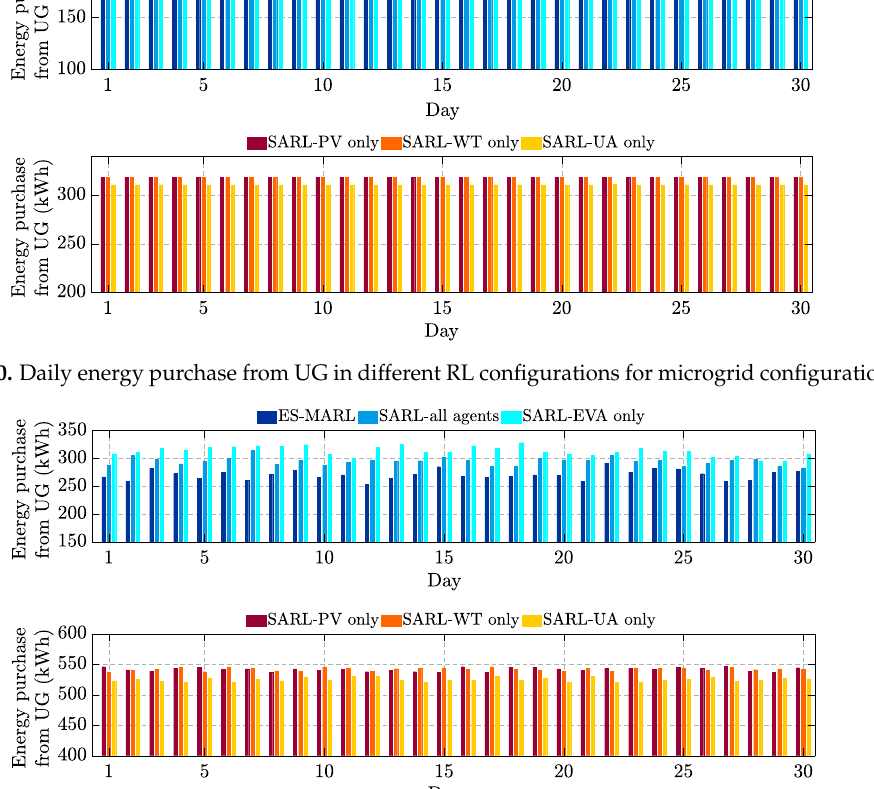
Figure 11. Daily energy purchase from UG in different RL configurations for microgrid configuration